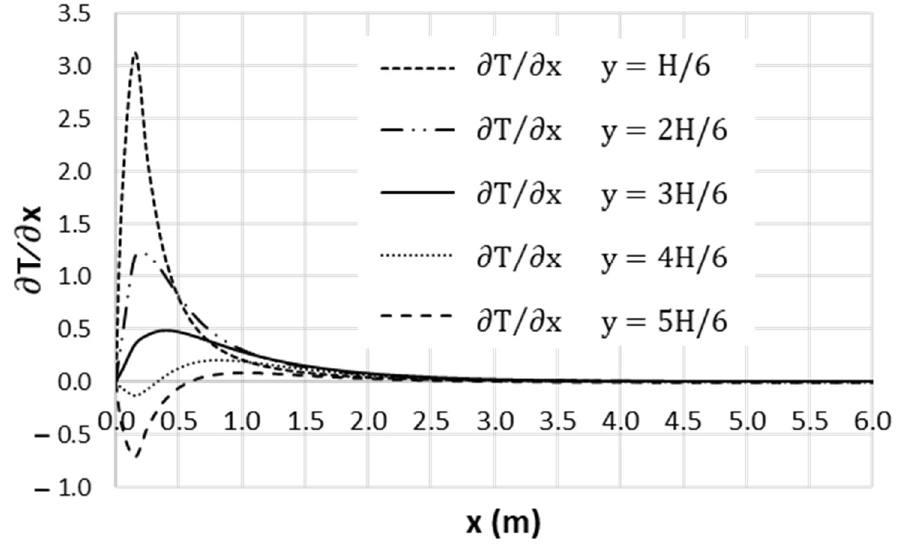
H (cid:2892) (cid:2873)(cid:2892) , 2H , 3H , 4H and 5H , (cid:2870)(cid:2892) , (cid:2871)(cid:2892) , (cid:2872)(cid:2892) and . Figure 6. Values of ∂ T/ ∂ x for Scenario III at y = 6 6 6 6 6 (cid:2874) (cid:2874) (cid:2874) (cid:2874) (cid:2874)